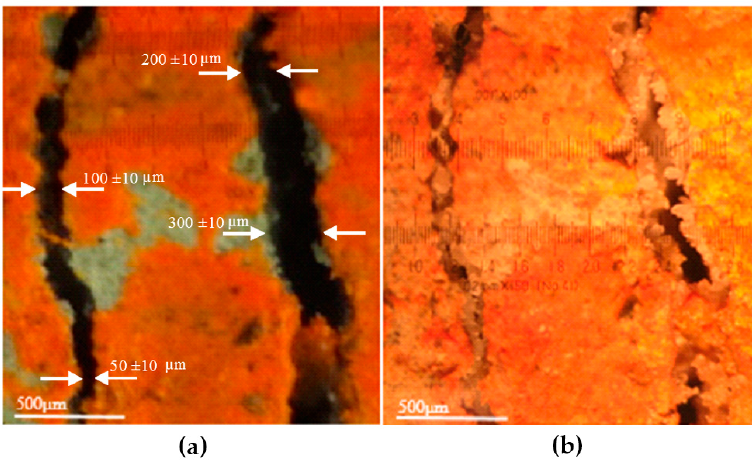
Figure 6. Crack healing process: ( a ) cracks before healing; ( b ) cracks after 42 days of healing.